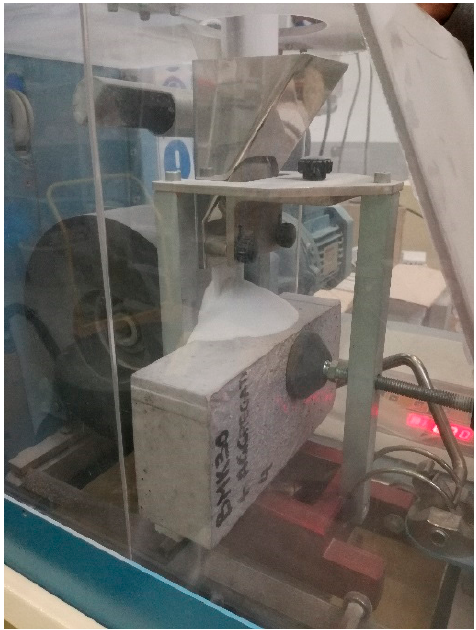
Figure 3. Wide Wheel Abrasion test on Paving Block Paste (PBP) sample.